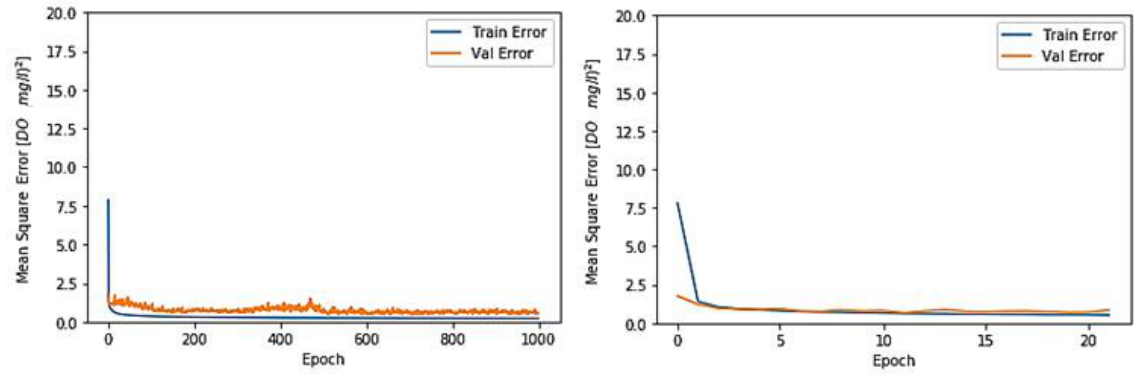
Figure 3 . Mean absolute error (Toichio station, structure 7-64-64-1).